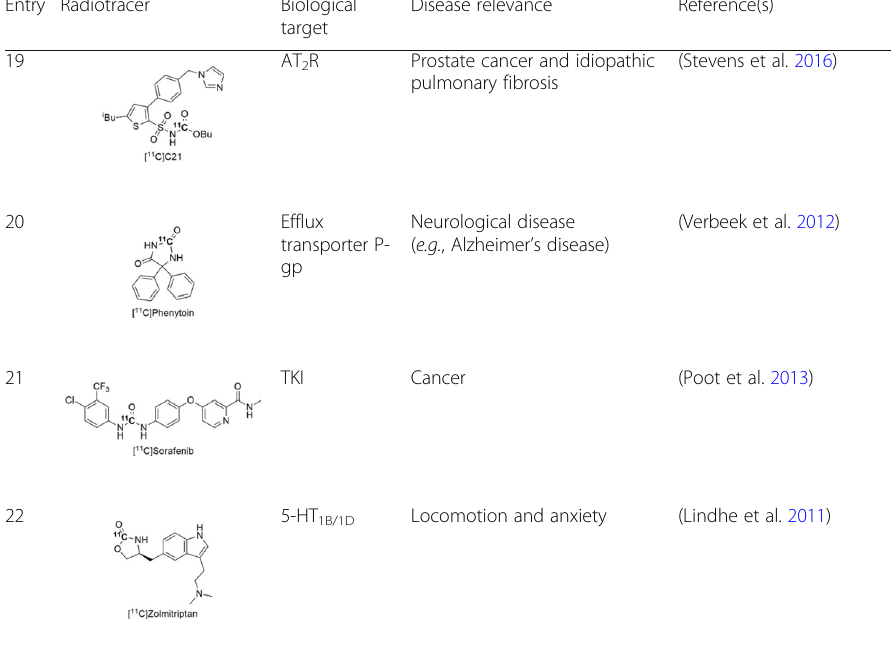
Table 1 Radiotracers radiolabeled using [ 11 C]carbon monoxide, the corresponding biological target, and disease relevance